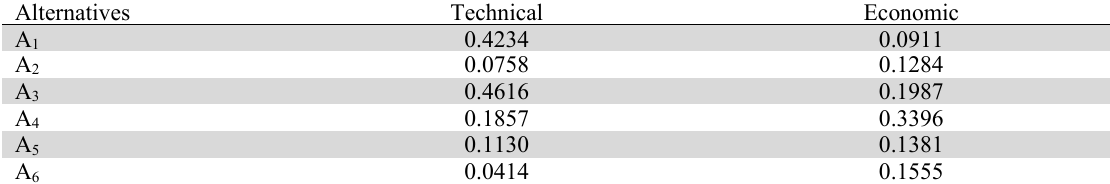
Normalised closeness coefficients for the technical and economic